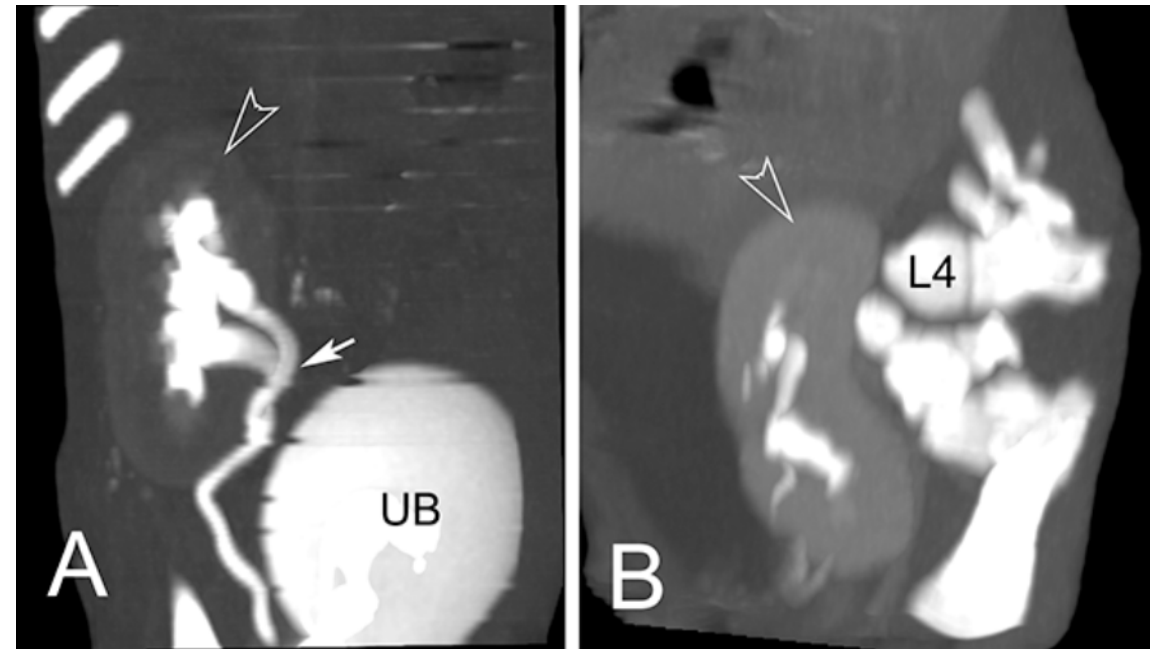
Figure 4. Post contrast CT of right ( A ) and left kidney ( B ) of the Piglet #1; Maximum Intensity Projection (MIP) in the dorsal plane. The kidneys (empty arrowheads) are moderately enhanced and most of the contrast medium is visible at the level of the pelvi, ureters and urinary bladder. The origin of the right ureter is duplicated (arrow). The left kidney is distorted by the compression exerted by the deformed last lumbar vertebrae. Legend: UB = urinary bladder; L4 = fourth lumbar vertebra.